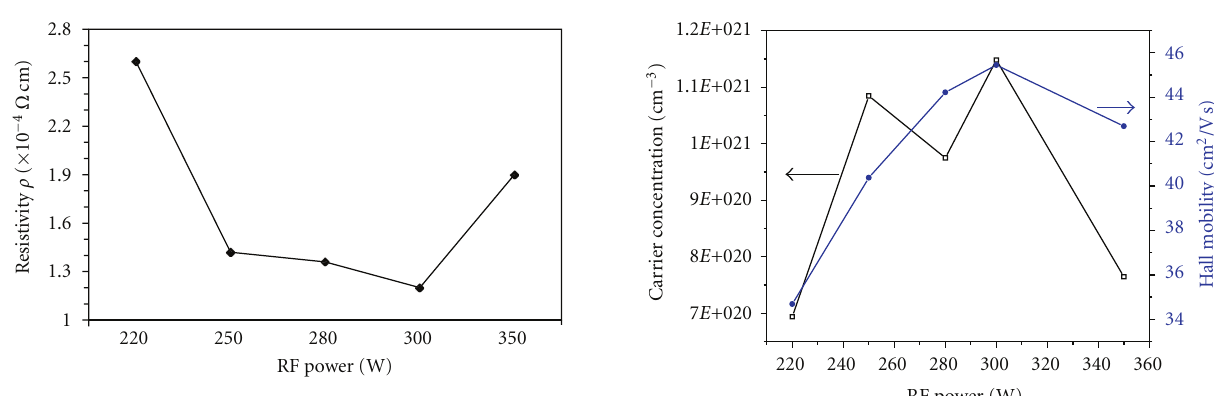
Figure 7: Carrier concentration and hall mobility with variations of RF